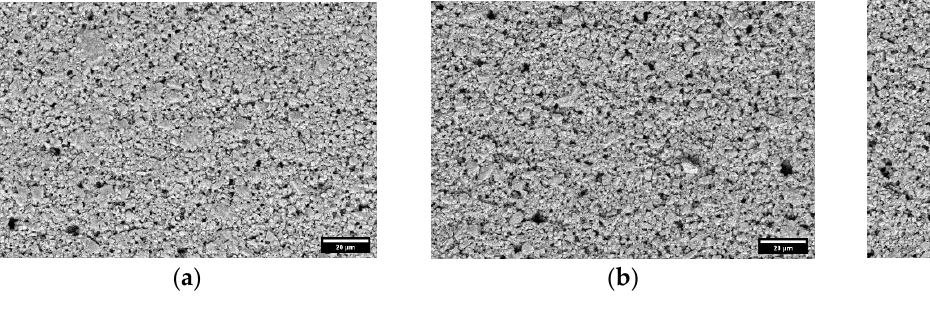
Figure 3. SEM micrograph images of ( a ) PUC, ( b ) PTC, and ( c ) PMC film surfaces on glass slides acquired using a back-scattered electron detector (BSD).